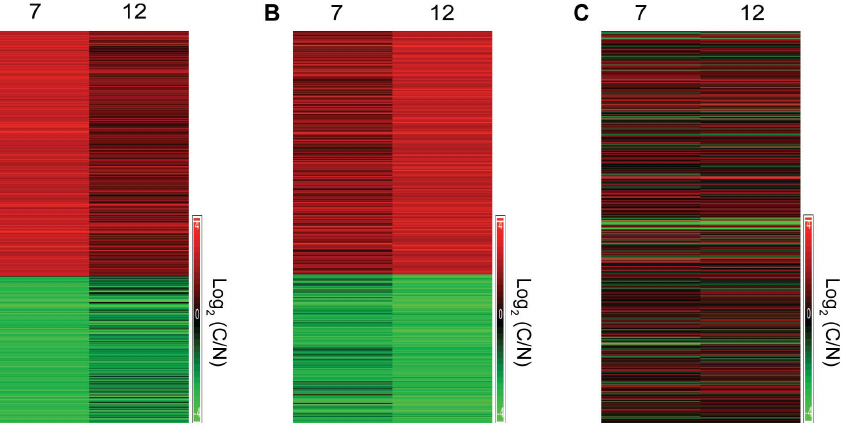
Figure 5. Heatmap of Mouse ID7 and Mouse ID12. A. Heatmap showing all transcripts that showed $ 4-fold change between carcinoma and normal skin in Mouse ID7 and their corresponding fold-change in Mouse ID12. B. Heatmap showing all transcripts that showed $ 4-fold change between carcinoma and normal skin in Mouse ID12 and their corresponding fold-change in Mouse ID12. C. Heatmap showing the fold-change of the transcripts that were significant in the average analysis, in Mouse ID7 and Mouse ID12.